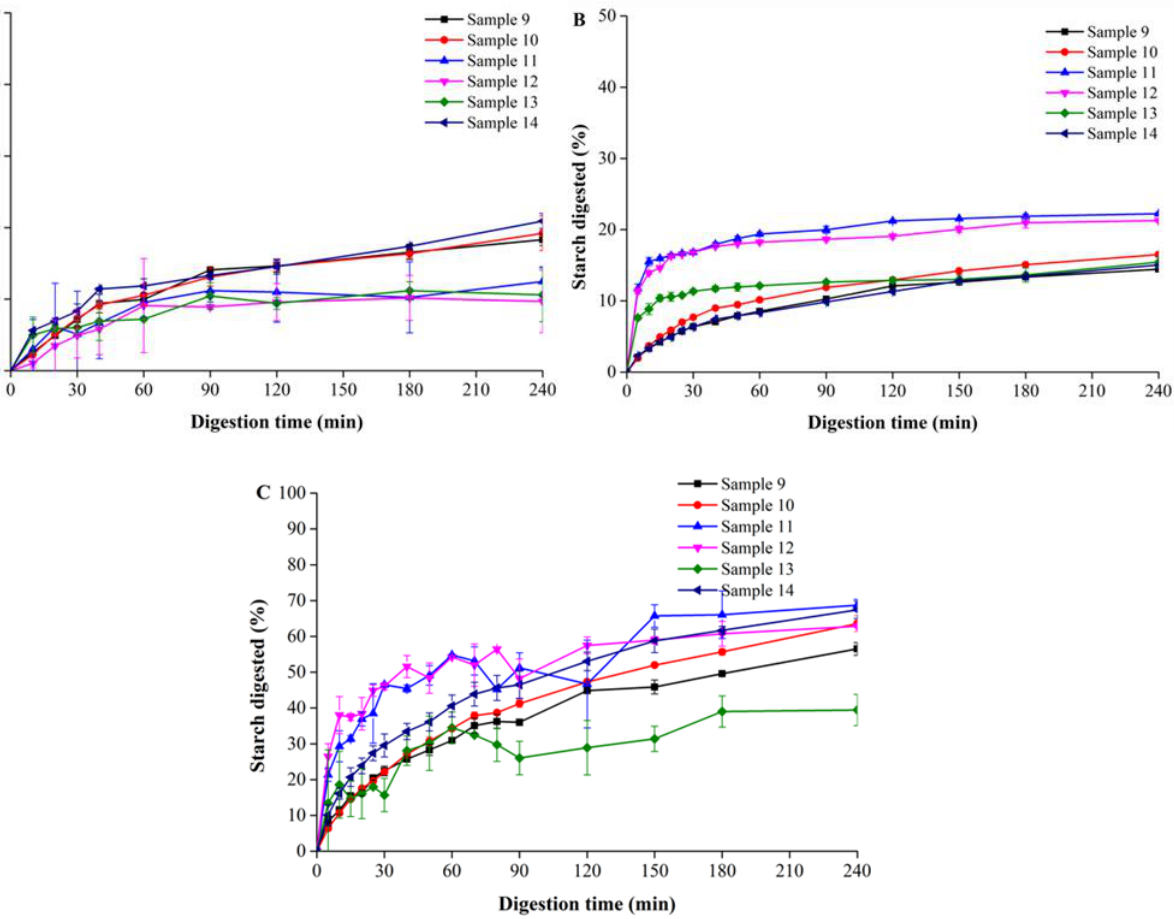
Figure 4. In vitro digestograms of all other commercial biscuits with different GI values using the INFOGEST ( A ) or single-enzyme digestion models by either porcine pancreatin ( B ) or pure α -amylase ( C ). Data is based on duplicate measurements.